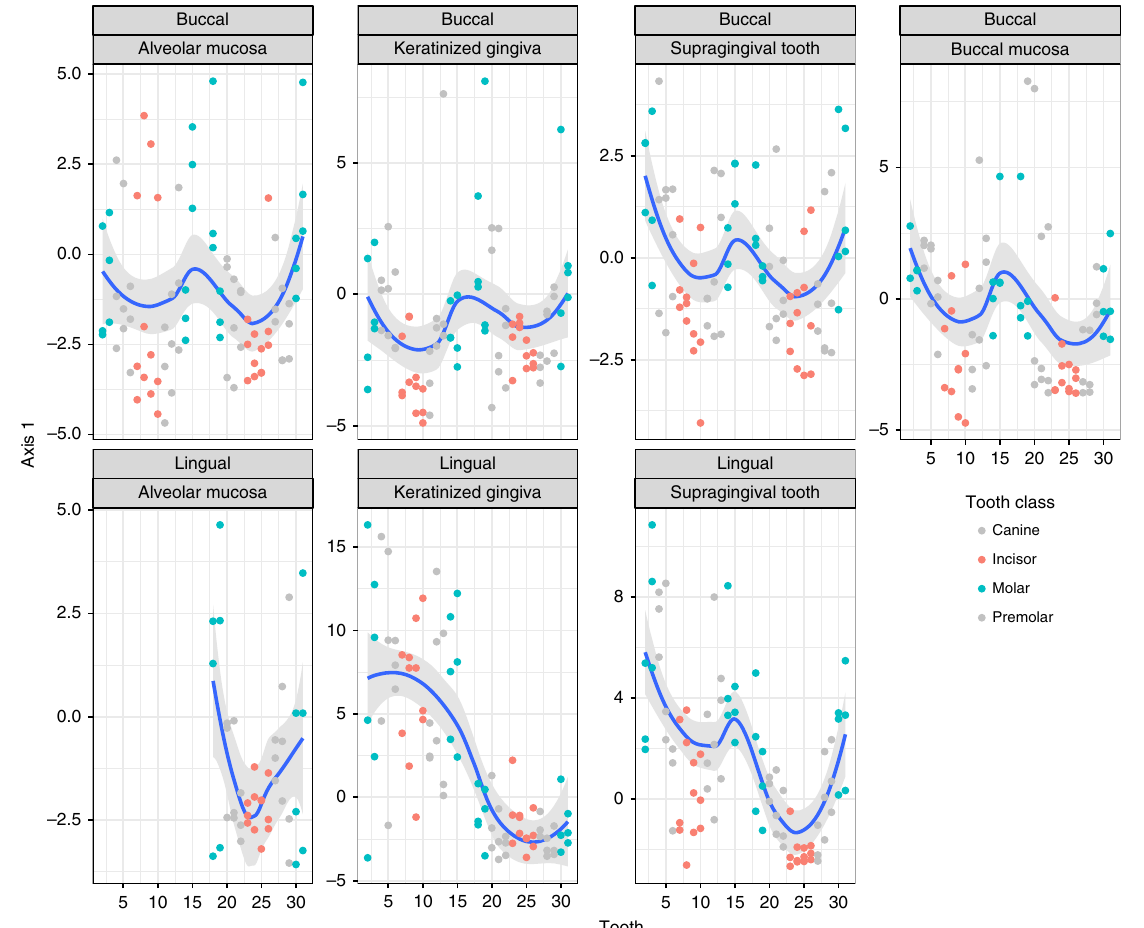
Fig. 3 Mucosal communities also vary along an anterior to posterior gradient. A trend surface analysis (TSA) on samples of the oral mucosa and supragingival surfaces of 3 additional individuals (101 taxa, 542 samples) captured 10.5% of the total variation in the data, with the fi rst axis accounting for 49% of the explained variance. TSA Axis 1 scores ( y axis) are plotted as a function of tooth number ( x axis). Each panel represents a unique tooth aspect (buccal, lingual) and intra-oral habitat (alveolar mucosa, keratinized gingiva, supragingival plaque, or buccal mucosa). Each point corresponds to a community sample, and samples are colored according to tooth class (molar, incisor, other tooth class). Blue curves denote local regression (loess) fi ts with associated 95% con fi dence intervals shaded in gray. Molar communities tended toward more positive scores along axis 1 compared to incisor communities, which tended toward more negative scores along axis 1 compared to molars. The remaining tooth classes were structured in an ordered fashion between the molar and incisor poles. These data suggest that both supragingival and soft tissue communities vary along a gradient from the front to the back of the